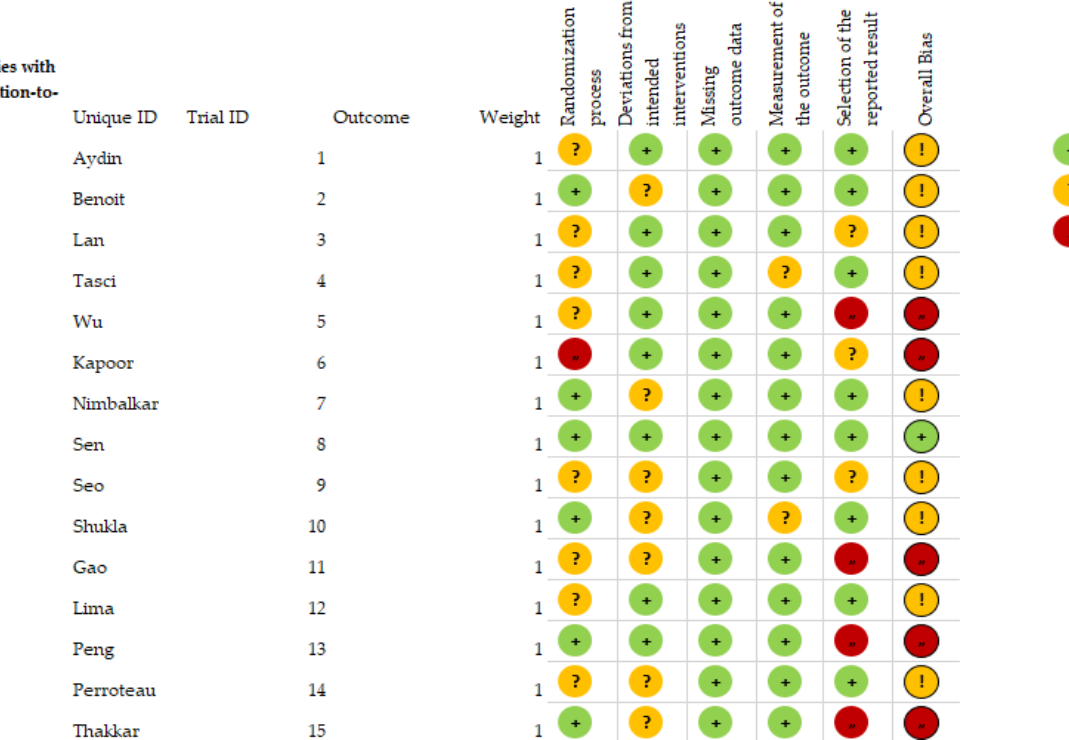
Figure 3. Risk of bias assessment for each included study.